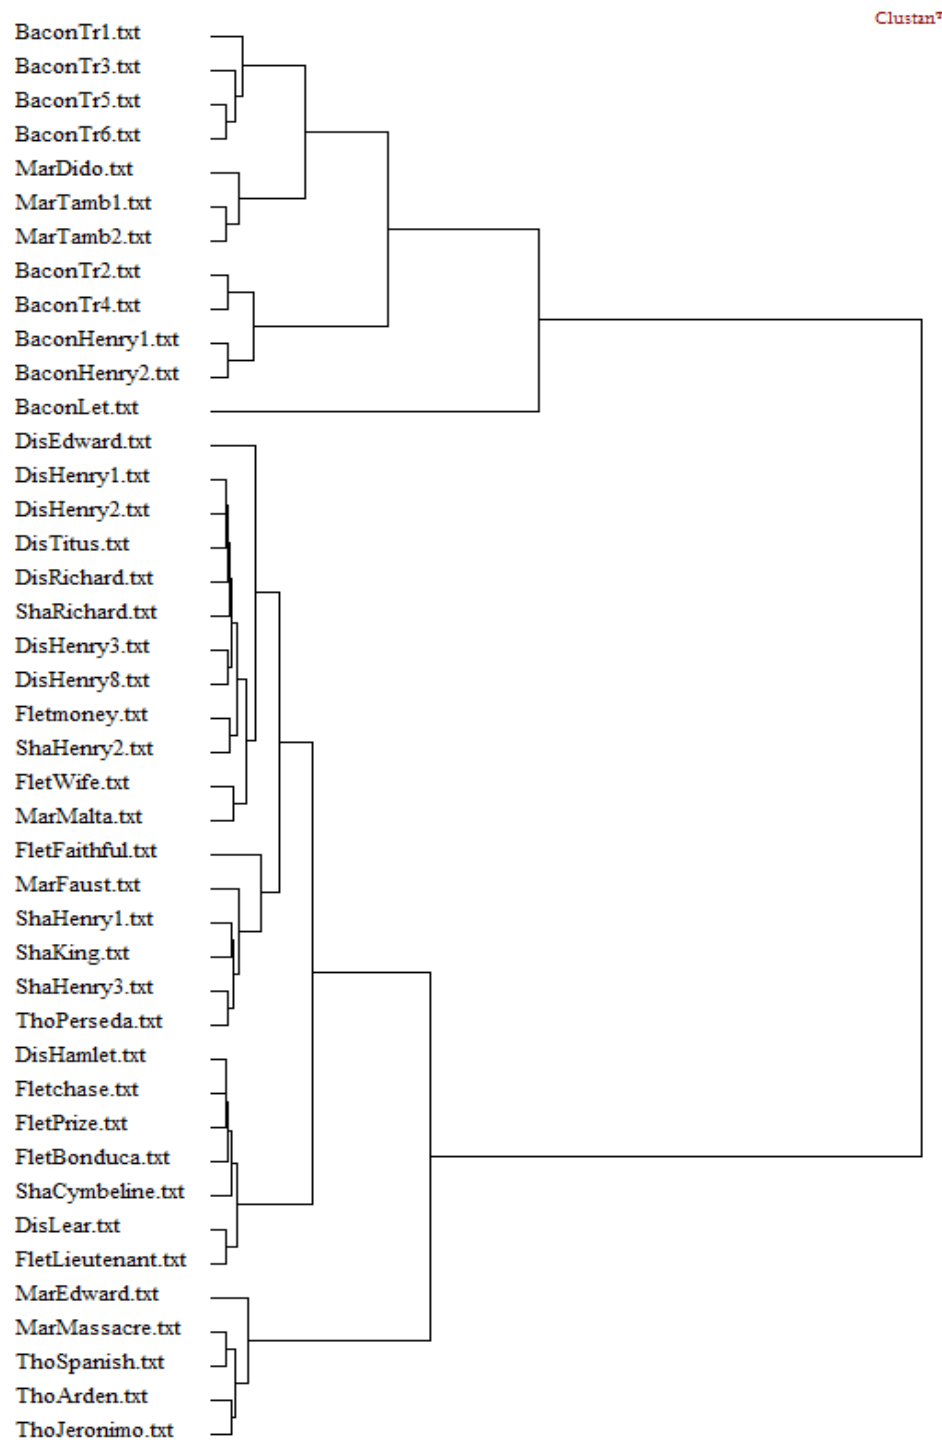
Figure 16. The hierarchical cluster analysis of D bigram using Product-Moment correlation and Mean